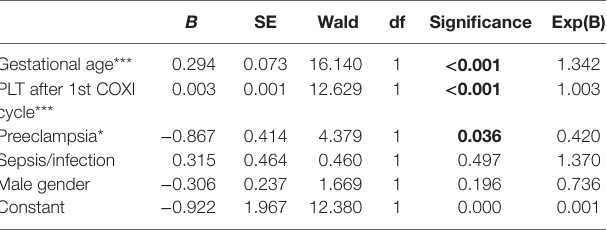
TaBle 3 | Logistic regression analysis for prediction of COXI treatment success.